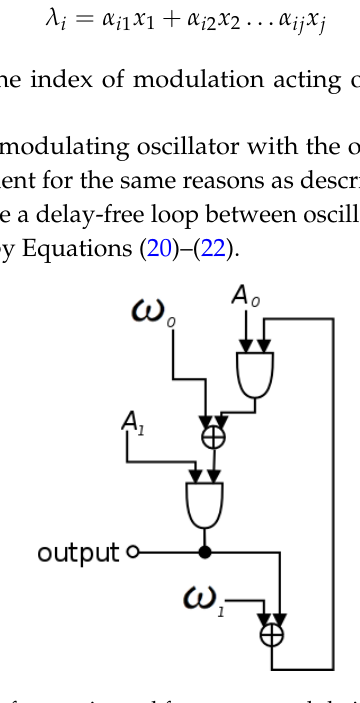
Figure 4. Signal flow diagram for a reciprocal frequency modulation (FM) scheme without